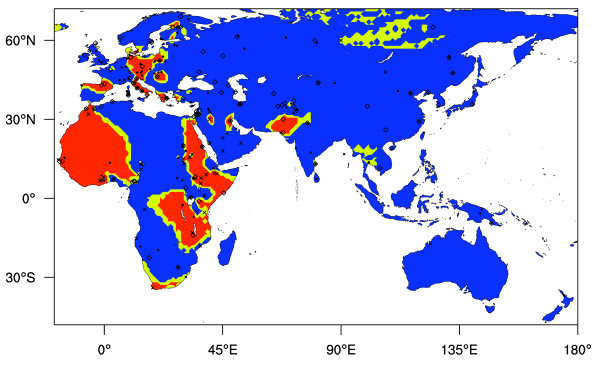
Old World LP genotype-phenotype correlation, obtained by the GenoPheno Monte Carlo test. Dots represent LP phenotype data collection locations, crosses represent data collection locations for all currently known 4 LP-correlated alleles, and diamonds represent collection locations for data on -13,910 C>T only. Colour key shows the p value obtained by the GenoPheno test. Red colour represents values of p < 0.01, indicating a highly significant lack of correlation, yellow colour represents values of 0.01 ≤ p < 0.05, indicating a significant lack of correlation, and blue colour represents values of p ≥ 0.05, indicating no significant lack of correlation.